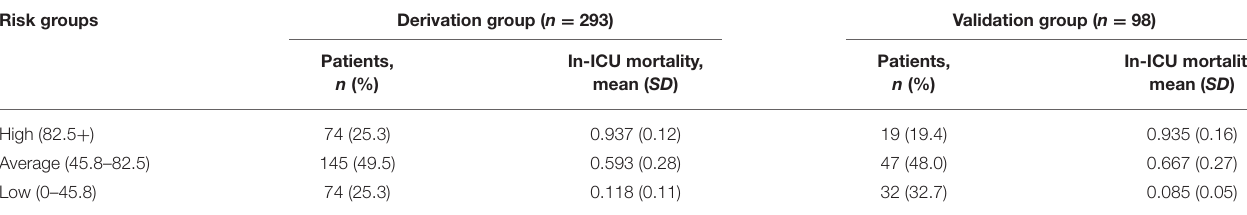
TABLE 7 | Patient risk stratification based on risk